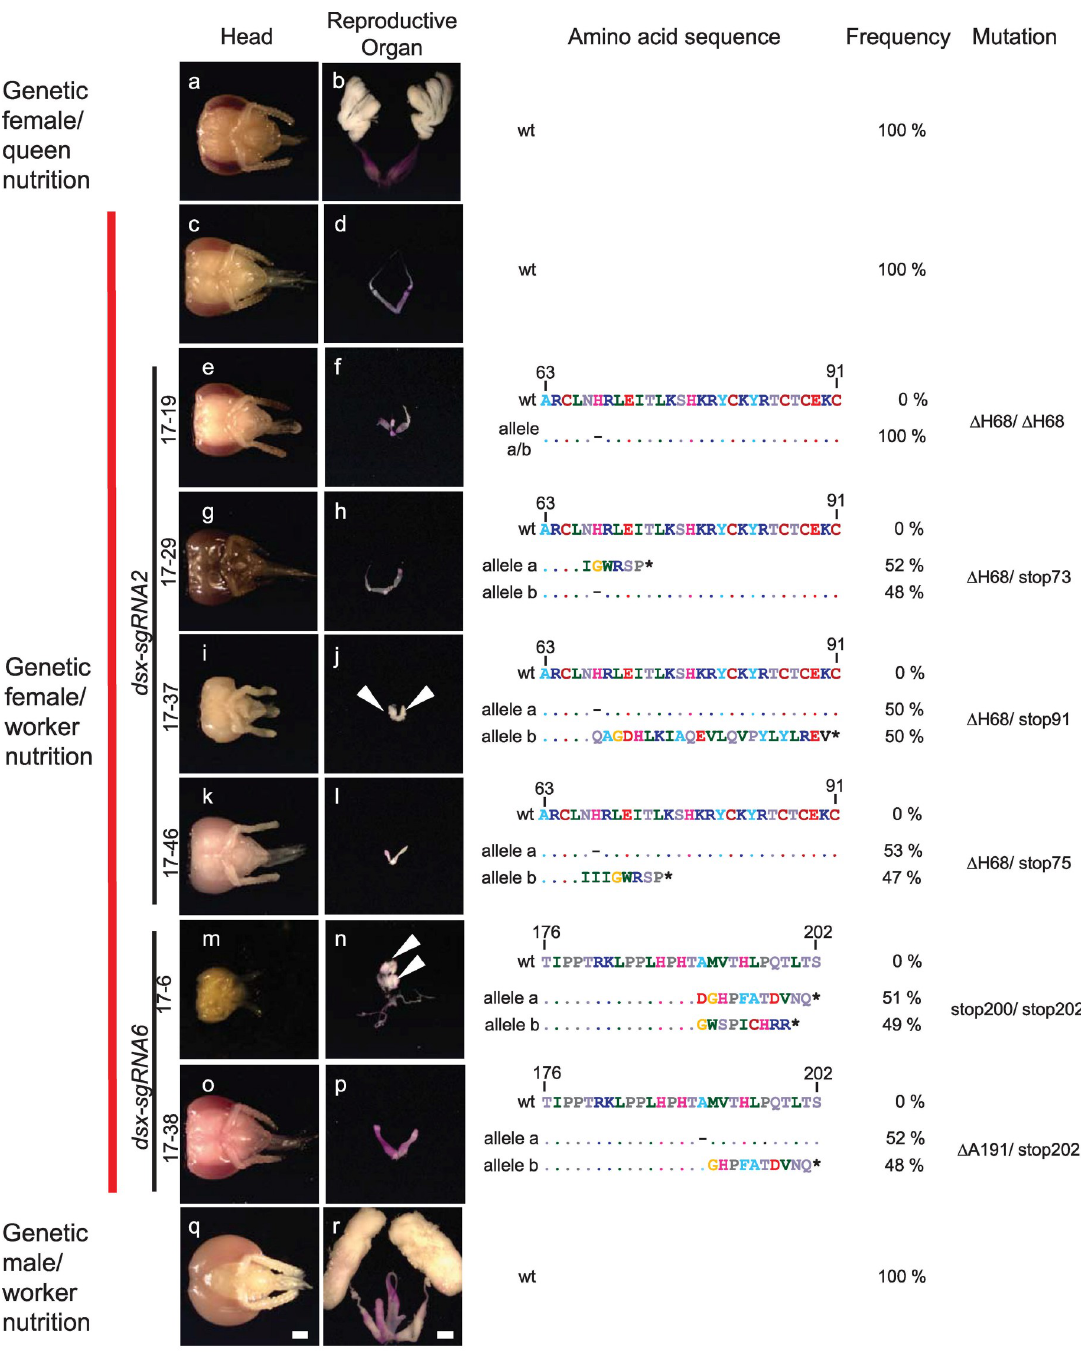
Fig 4. Size polyphenism of the reproductive organs in genetic female double mutants for the dsx gene. Pictures of the head and internal reproductive organs of mutated and WT control bees are shown on the left, while the genotypes at the dsx locus with the deduced amino acid sequences are displayed on the right. Mutated and control genetic females and males were reared on worker nutrition. Queens were reared on the queen diet in a colony (we cannot mimic queen rearing in the laboratory). The WT amino acid sequence is shown above the detected alleles for comparison. (a, b) WT genetic female reared on queen nutrition (RJ) in the colony. (c, d) WT genetic females manually reared on worker nutrition. (e–l) Genetic females reared on worker nutrition that were double mutants for dsx via the dsx-sgRNA6 (note that a small part of the worker bee head 17–39 [picture i] is missing due to the dissection process). (m– p) Genetic females reared on worker nutrition that were double mutants for dsx via the dsx-sgRNA2 . (q, r) Genetic males manually reared on worker nutrition. Organs were stained with aceto-orcein (reddish coloring) to facilitate the dissection process. Testis tissues